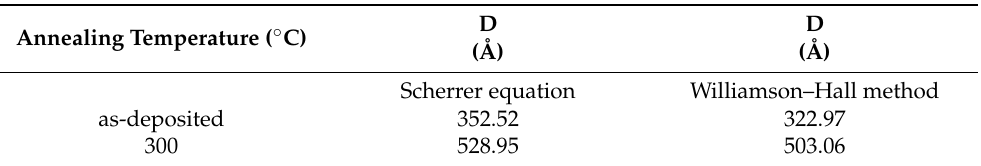
Table 1. Grain size (D) values of ZnS with a peak intensity of (103) plane using Scherrer equation and the Williamson–Hall method.